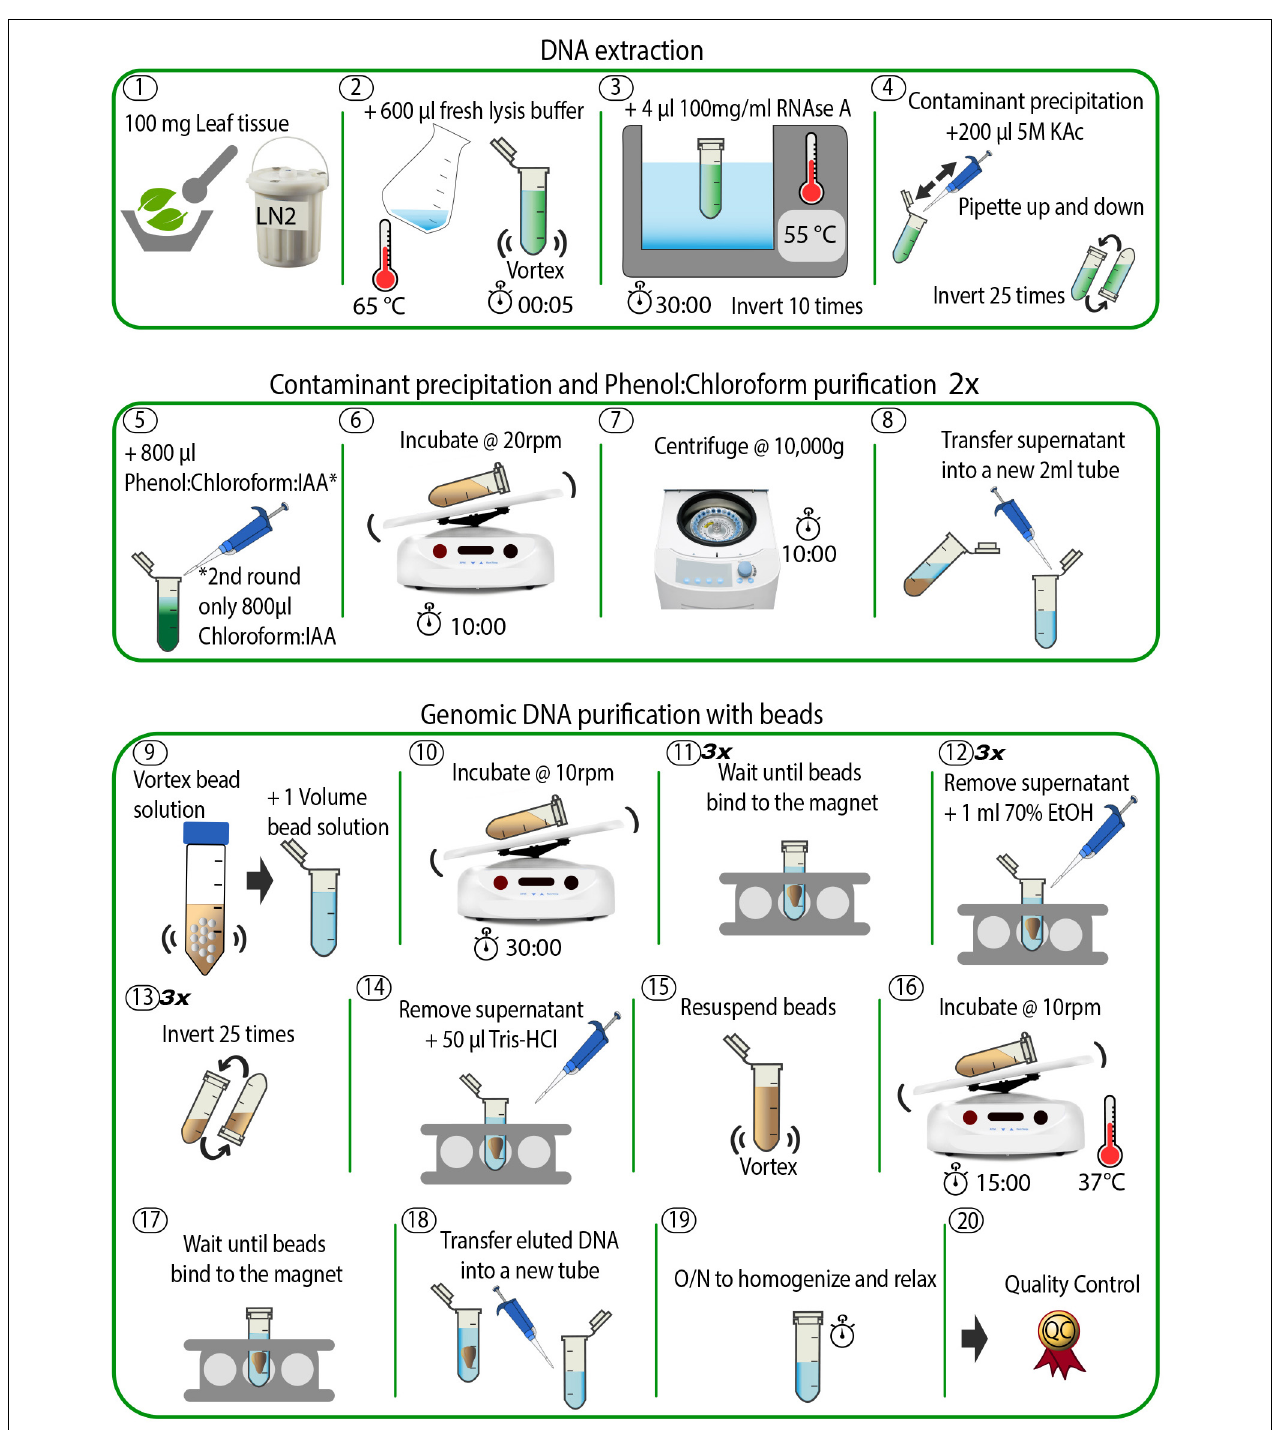
FIGURE 1 | Schematic overview of the DNA extraction method. The individual steps are described in detail in the see section “Methods” and in the accompanying online protocol.